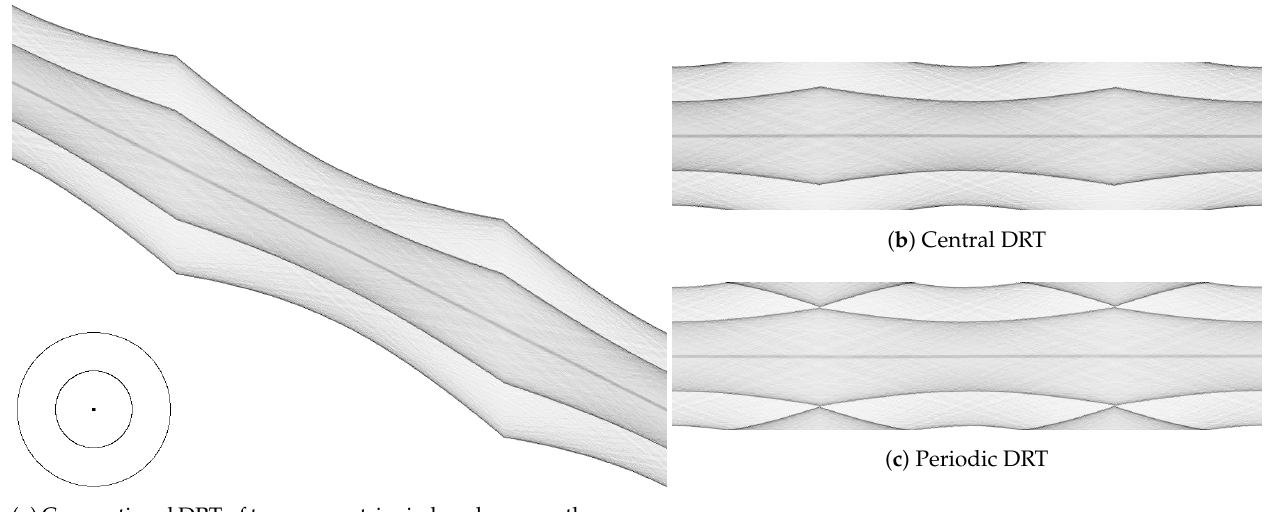
Figure 16. Conventional DRT ( a ), Central DRT ( b ), and Periodic DRT ( c ) of a 256 × 256 image of two concentric circles, shown bottom left of first